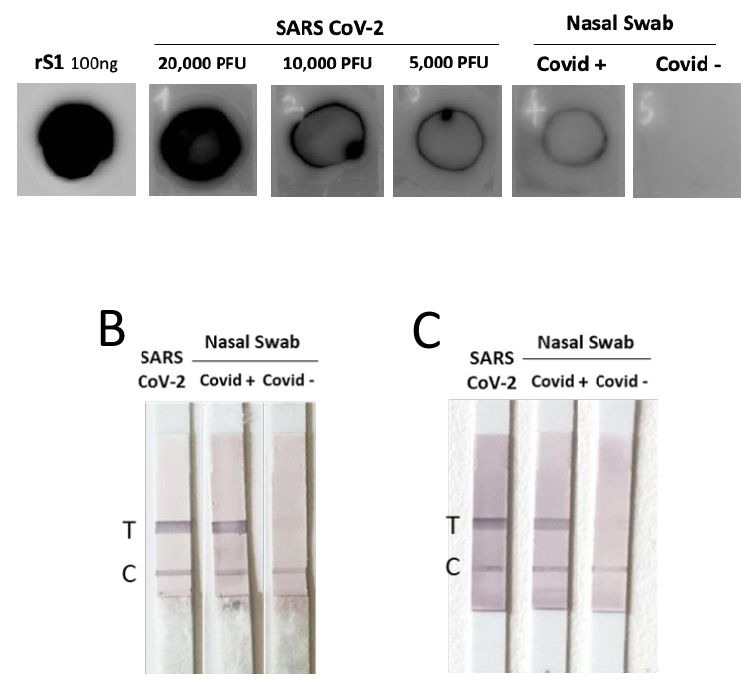
Figure 7. A preliminary proof-of-concept for the possibility to use the isolated mAbs are tools for an antigenic diagnostic assay. Dot blot assay of mAb specific for the S1 domain (S71). On PVDF membrane recombinant rS1, supernatant of Vero E6 cells infected with SARS-CoV-2 or nasal swabs from COVID-19-positive patient (Covid+) and from a control healthy subject (Covid − ). ( A ) One experiment representative of three is shown. ( B , C ) Lateral flow assay with two pairs of anti-S1 mAbs to detect the antigen in the supernatant of Vero E6 cells infected with SARS-CoV-2 or nasal swabs from a COVID-19-positive patient (Covid+) and from a control healthy subject (Covid − ). In B, the capture mAb is S71 and the detector mAb is S79; in C, the capture mAb is S71 and the detector mAb is S12.